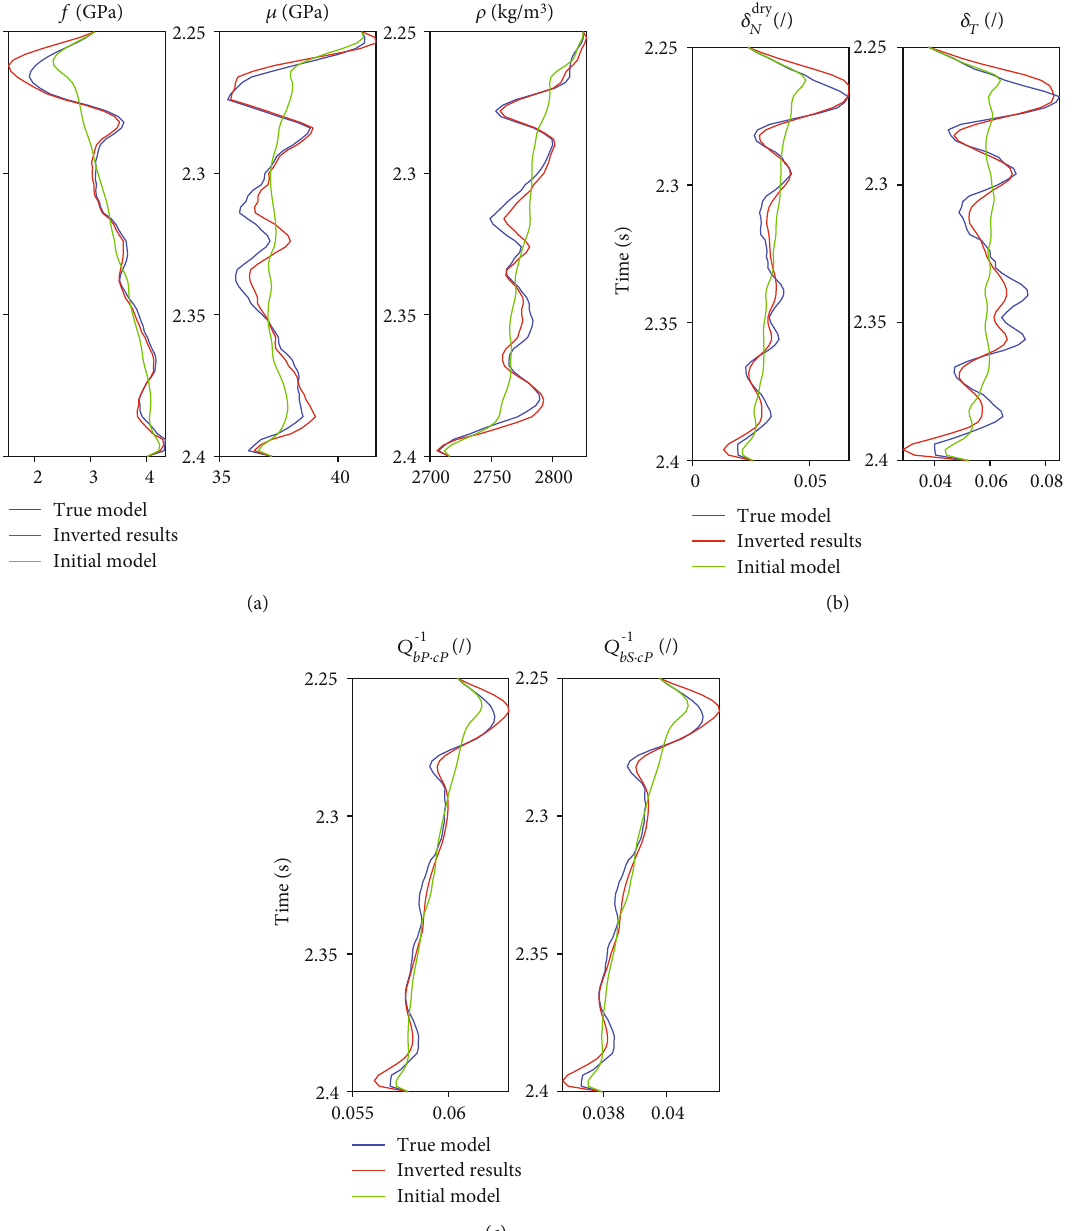
Figure 2: Estimated model parameters using the azimuthal attenuation EI inversion with no noise, where (a) shows the fl uid/porosity term, shear modulus, and density; (b) shows the normal and tangential fracture weaknesses; and (c) shows the attenuation